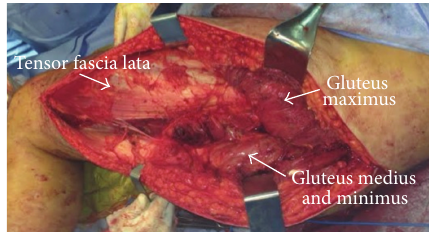
Figure 3: Intraoperative image showing the urgent fasciotomy and the decompression of the three gluteal compartments (tensor fascia lata, gluteus minimus and medius, and the gluteus maximus) with distal extension through the left